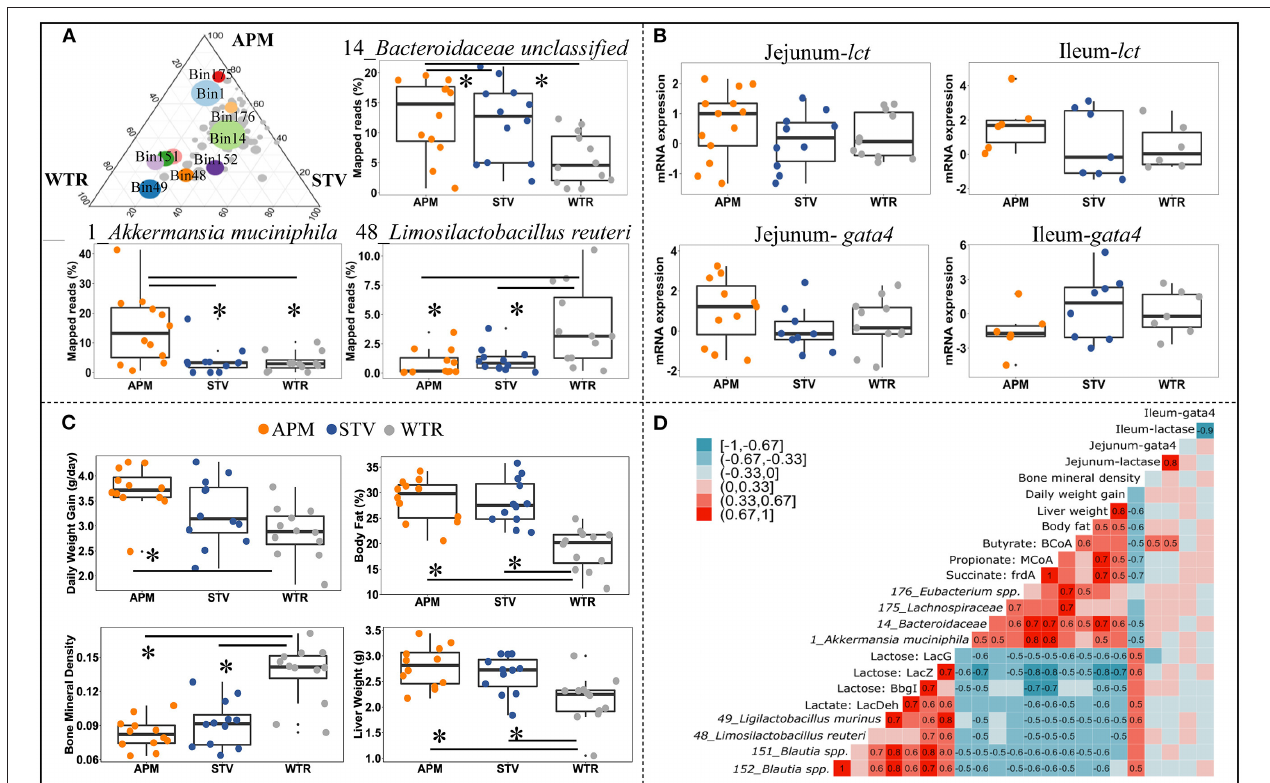
FIGURE 5 | Connections between cecal microbiome alterations and host parameters in 3-week old offspring. The top 10 influenced genomes in cecal microbiota of 3-week-old offspring (ternary plot) and the relative abundance of 3 representative influenced genomes (boxplots) (A) ; mRNA expression fold change of jejunal/ileal lactase gene ( lct ) and GATA4 ( gata4 ) (B) ; Growth peformance and body composition of weanlings (C) ; The coefficient matrix of Spearman’s rank correlations between the most influenced genomes, metabolic enzymes, gene expression, and the corresponding growth and body composition of 3-week old offspring (D) . Data with asterisk (*) represents significant difference ( p < 0.05). APM, aspartame; STV, stevia; WTR, water